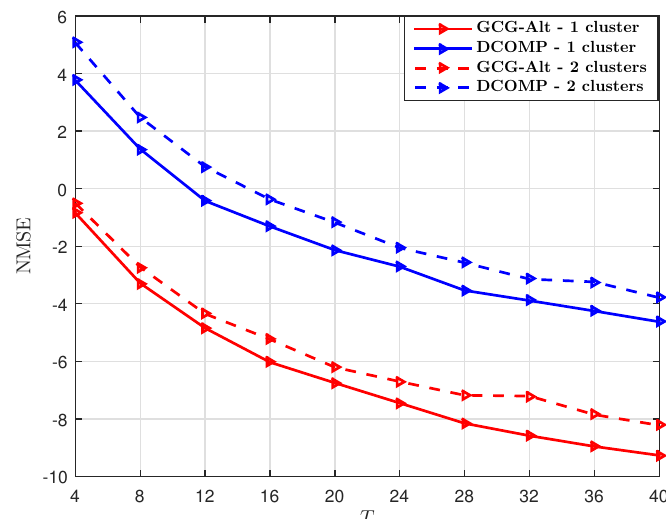
Figure 4. Comparison of NMSE of the GCG-Alt estimator and the DCOMP estimator under the ULA system, where N t = 64, N r = 16,PNR = 10 dB, and S = 32.